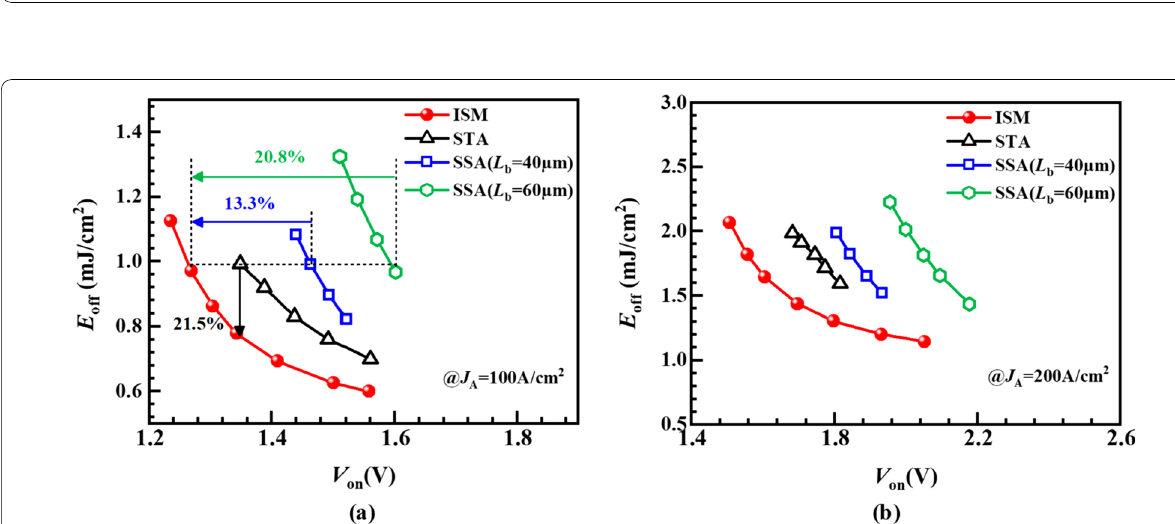
Fig. 7 a Turn-off waveforms under clamped inductive load with L C for the ISM RC-LIGBT at anode side [at point A in ( a )]